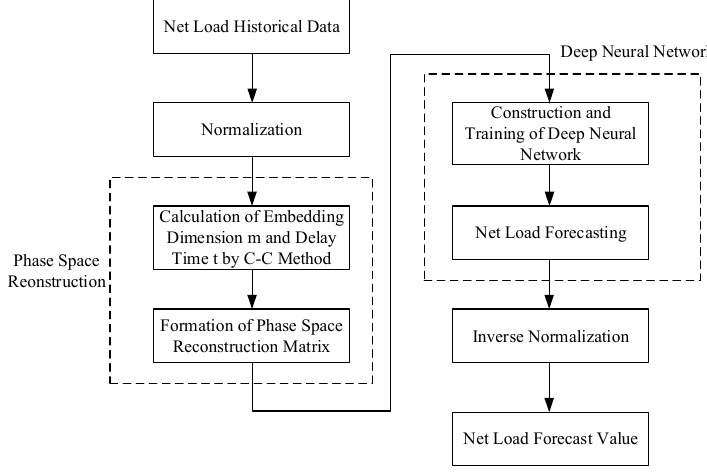
Figure 2. Forecasting model flow chart.